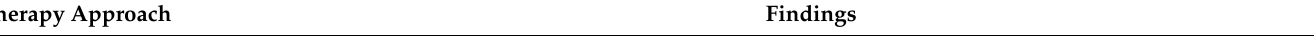
Table 1. Experimental therapy strategies employed in mouse models of pulmonary fibrosis induced by Paracoccidioides brasiliensis infection.